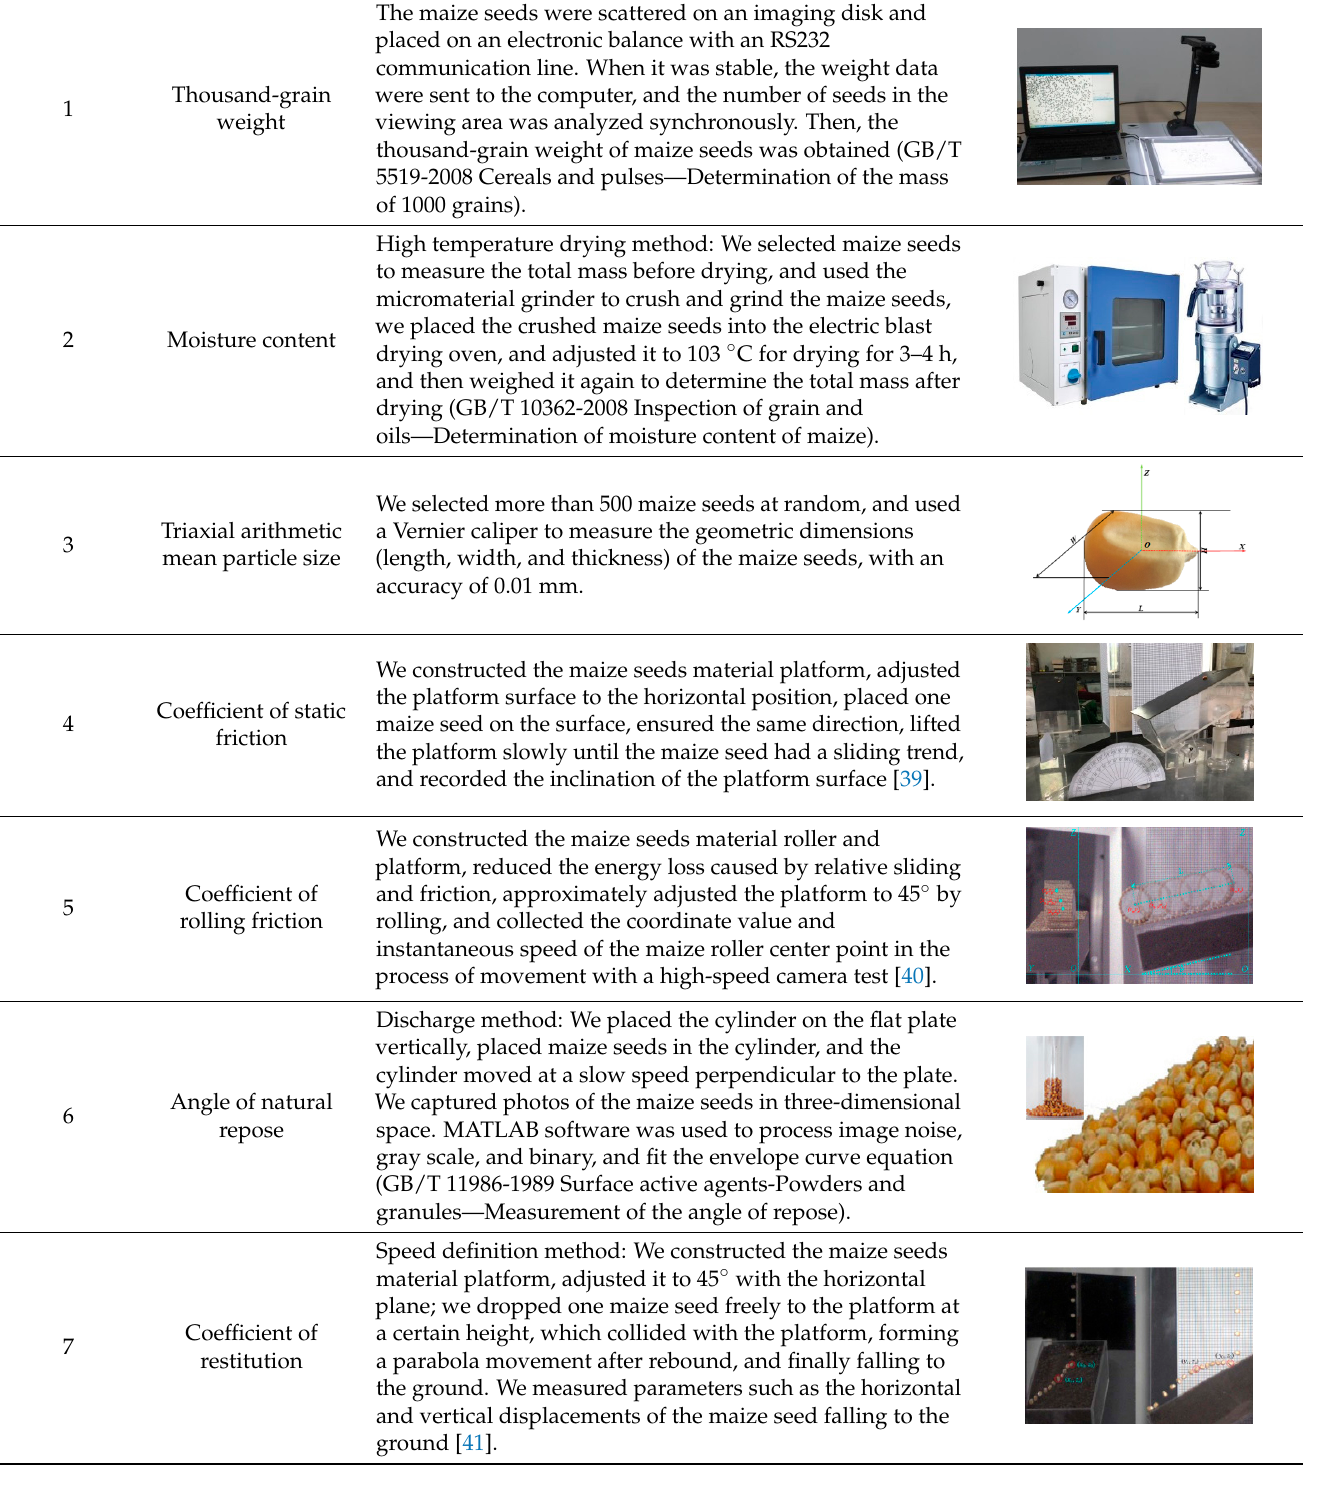
Table 2. Principles, methods, and instruments used for measuring the physical characteristics of maize seeds. No. Project Test Principles and Methods Instrument and Test Bench